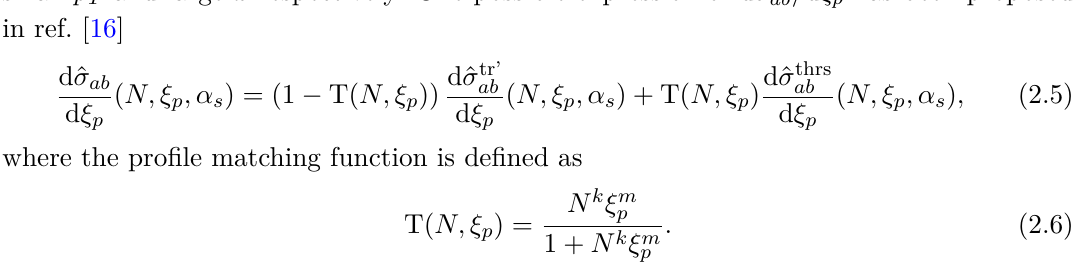
/ d ξ has been proposed p ab